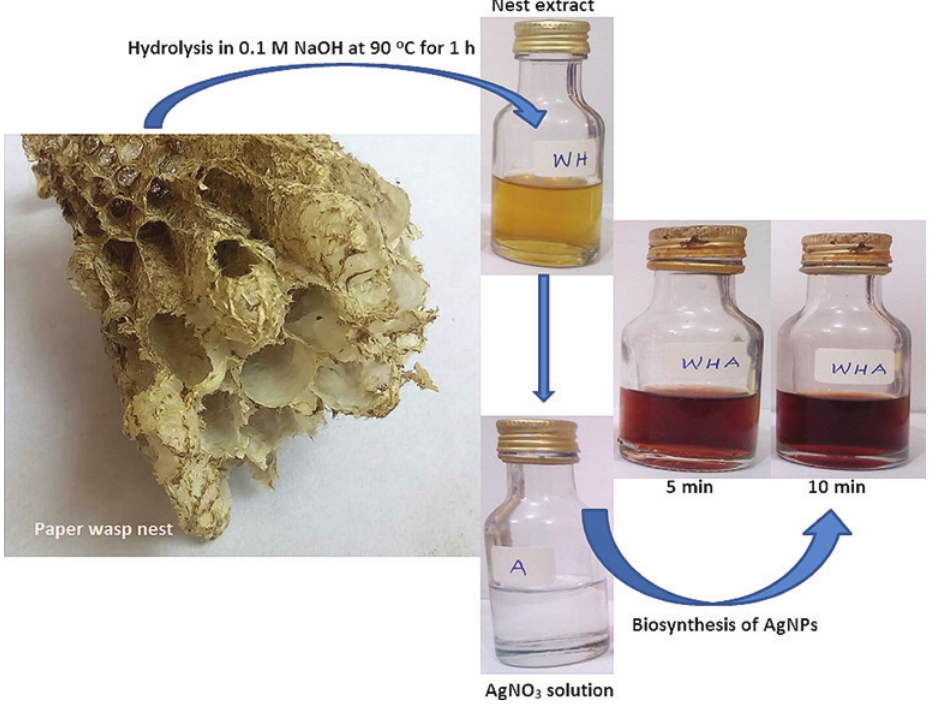
Figure 4: The biosynthesis of AgNPs using paper wasp nest extract. properties [150, 151]. It is of great importance as a natural antioxidant for applications in food, pharmaceutical, cosmetic, and biomedicine [152]. In investigating